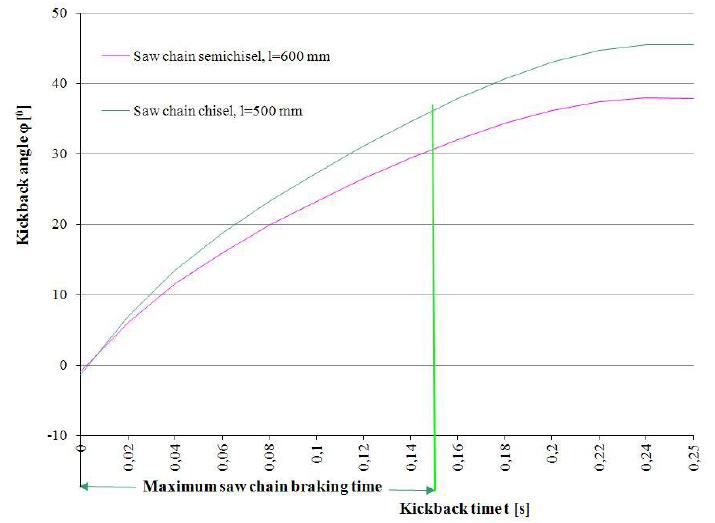
Figure 9. Sample changes in kickback angle over time, with respect to maximum saw chain stopping time. l: guide bar length; engine velocity: 150 s − 1 ; maximum calculated final uncertainty of kickback angle: ±2°.